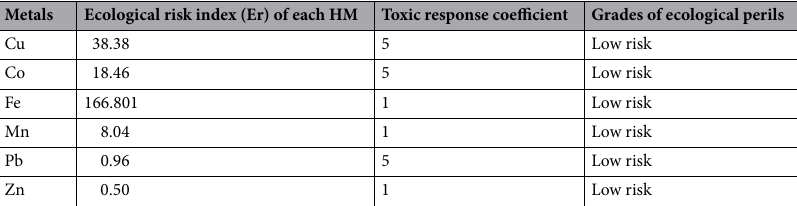
Table 6. Calculated potential ecological risk index and toxic response coefficient level.